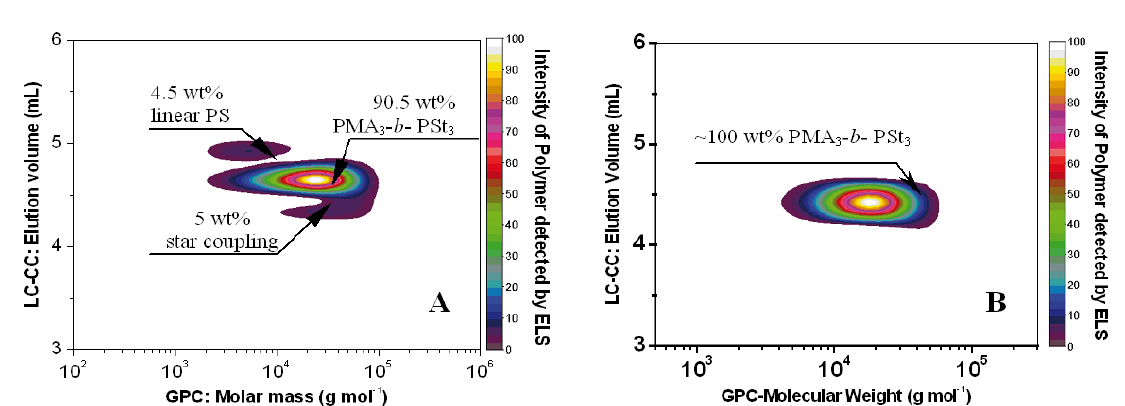
Figure 1. 2-Dimensional contour plots of the resulting 3-arm block copolymer synthesized using 3-arm trifunctional PMA macroinitiator via SR&NI ATRP (A) and AGET ATRP (B) in an aqueous styrene miniemulsion. In the 1 st dimension, values were obtained with liquid adsorption chromatography at the critical condition (LC-CC) of PSt, and in the 2 nd dimension, with gel permission chromatography (GPC). Signal was collected by evaporative light scattering (ELS) detector [80]. Reproduced with permission from the American Chemical